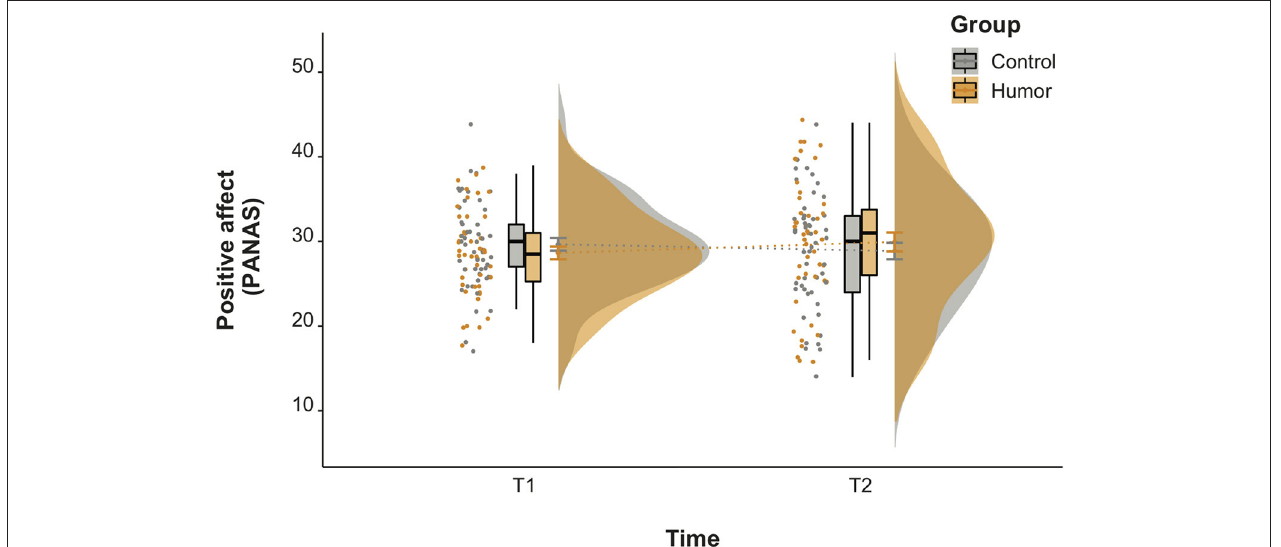
FIGURE 3 | Positive affect before (T1) and after (T2) watching the neutral (control group) or funny (humor group) video clips.